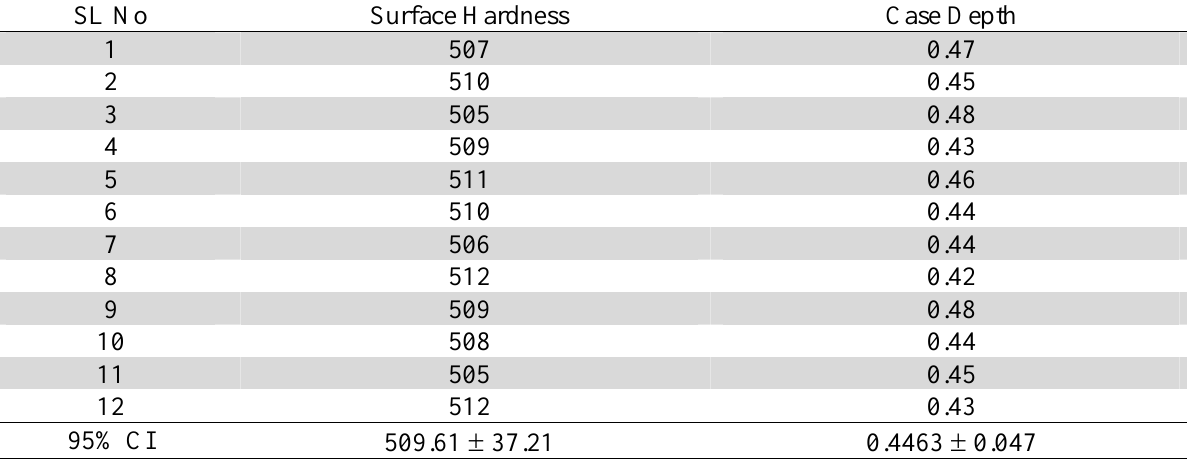
Pilot implementation